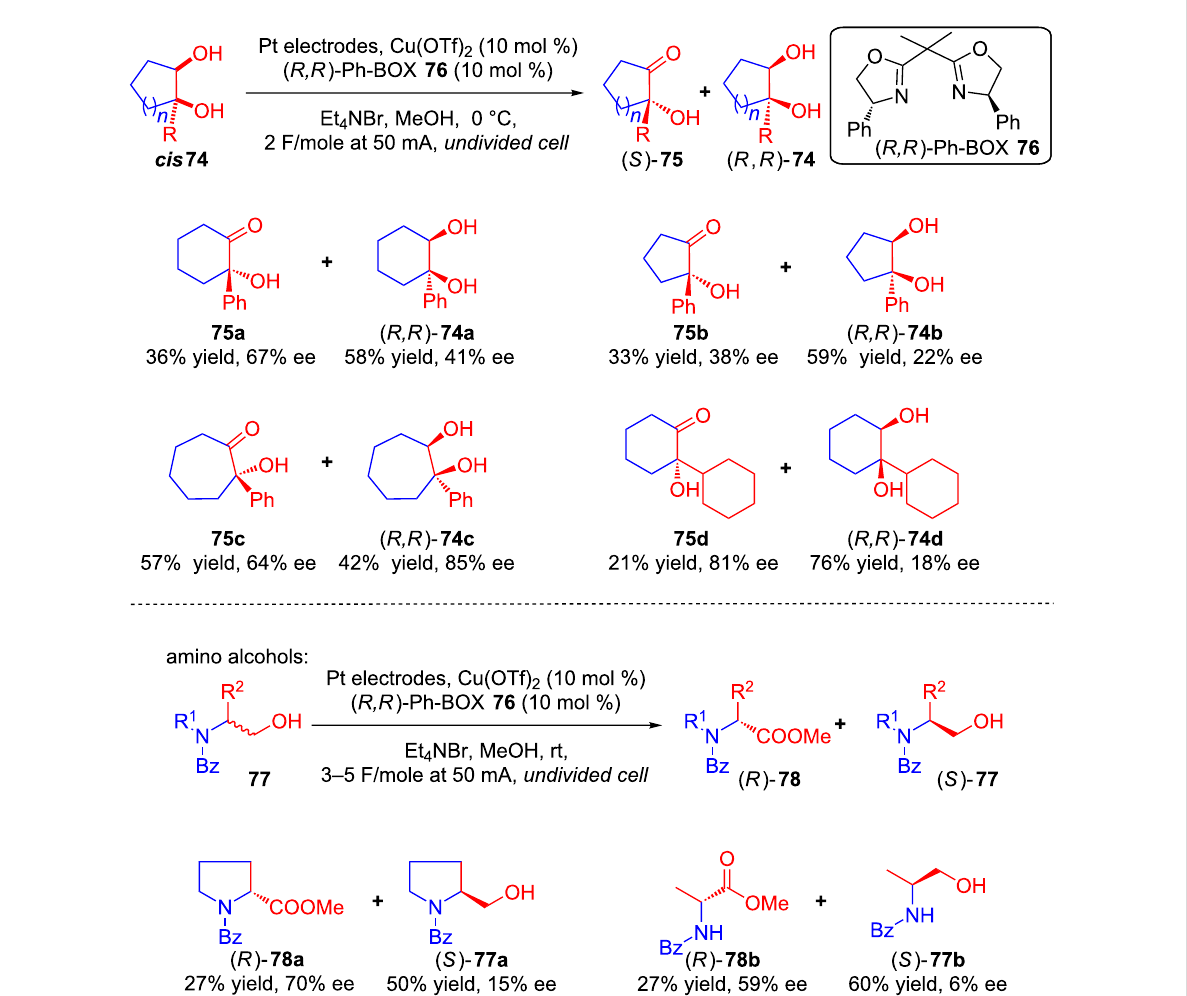
Scheme 29: Asymmetric electrooxidation of 1,2-diols, and amino alcohols using a chiral copper catalyst.